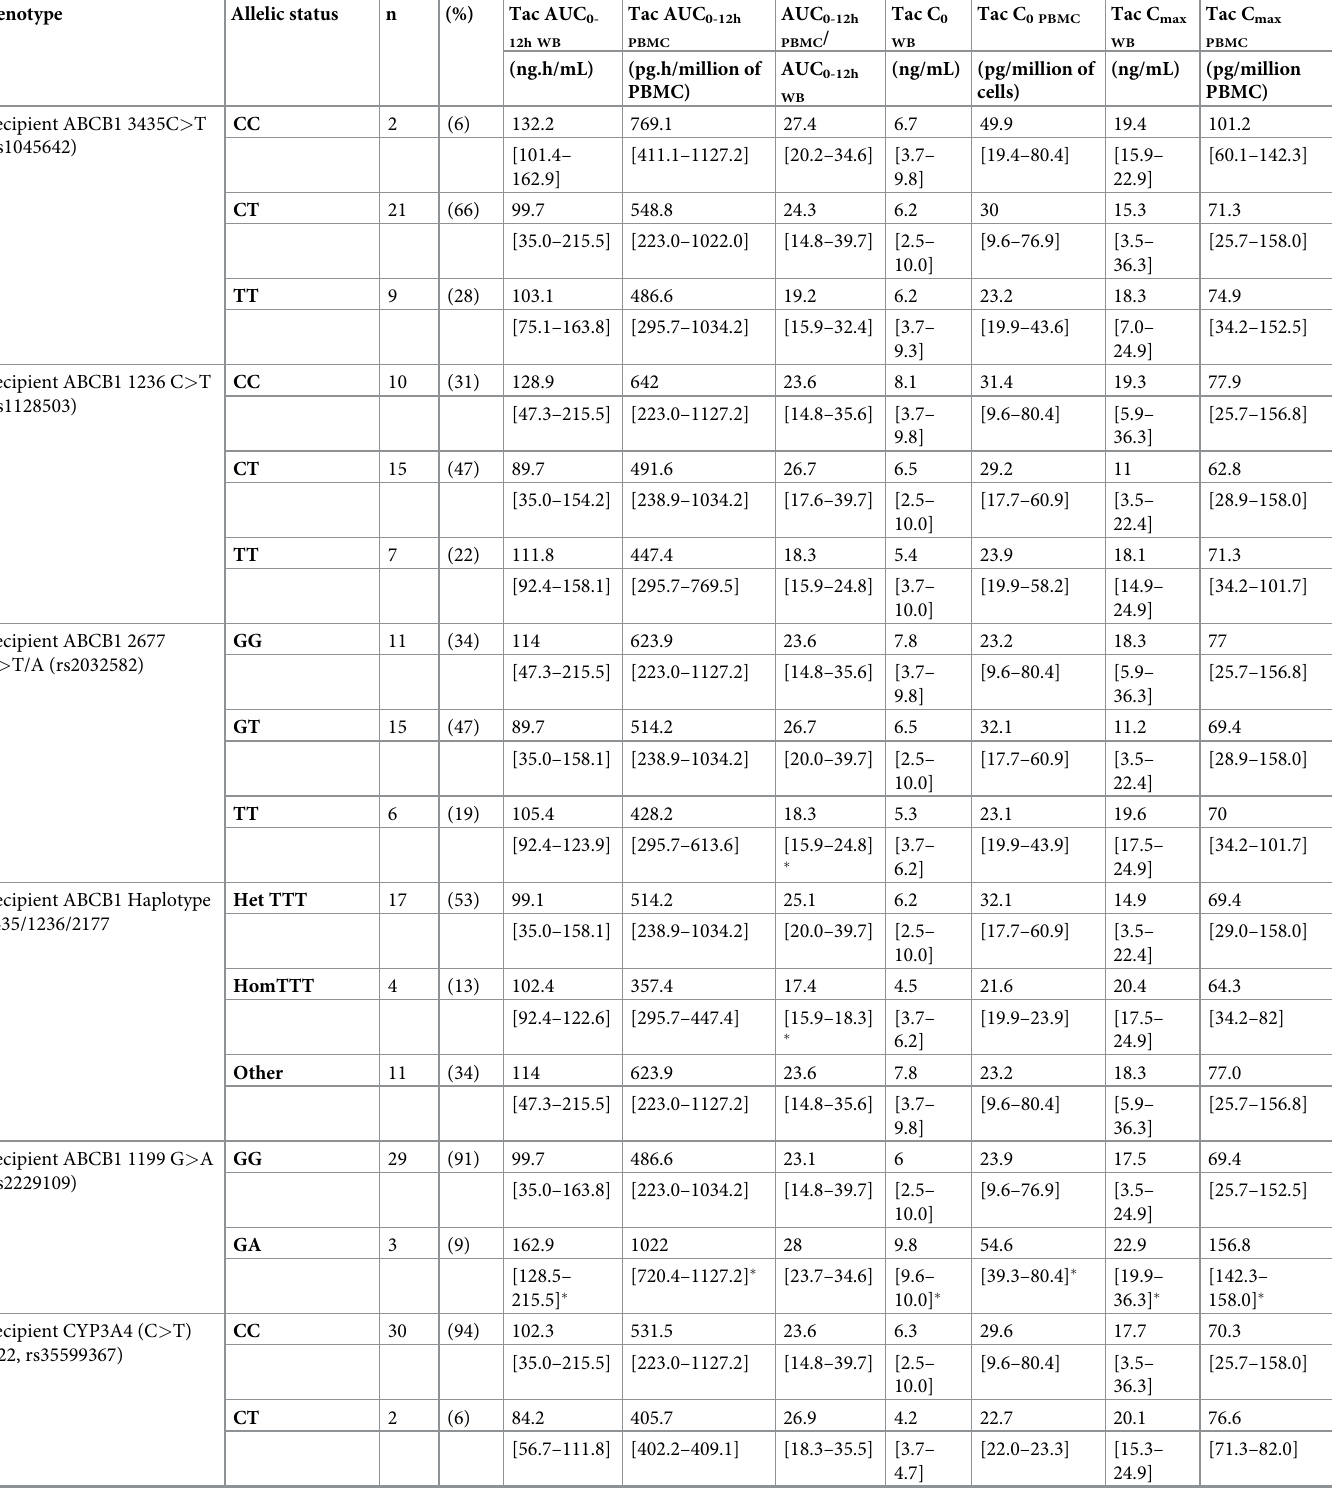
Table 3. Influence of single nucleotide polymorphisms on TAC pharmacokinetics in whole blood and in PBMC.